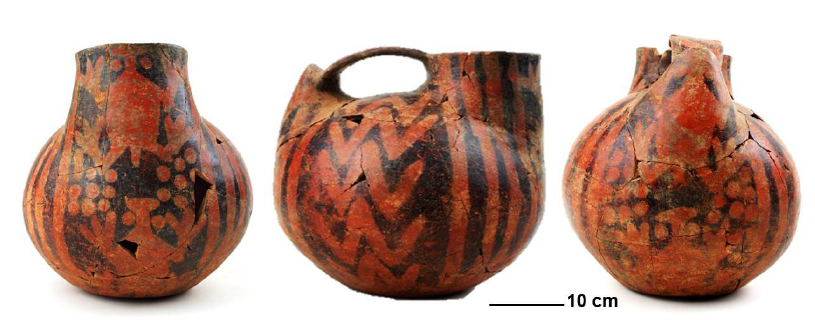
Figure 5. Vessel from the JMC-01 Labraza archaeological site; image from Viviana Rivas, Fondart Project 21511-2. Courtesy of Doina